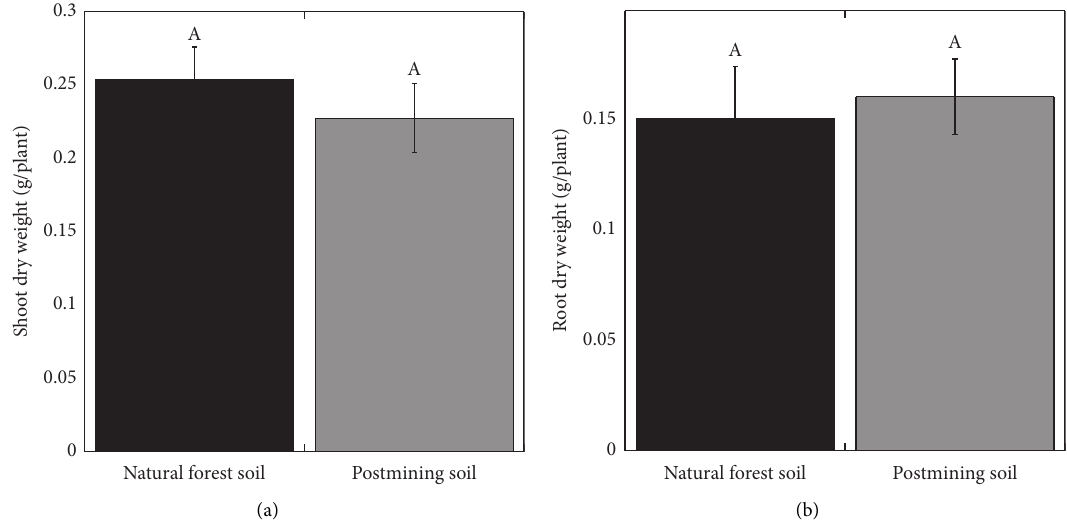
Figure 5: Mean shoot (a) and root (b) dry weight of Albizia saman 15 weeks after planting in soil from post-nickel mining land and natural forest. Different letters indicate significant differences ( P � 0 . 05). Error bars indicate standard error ( n �